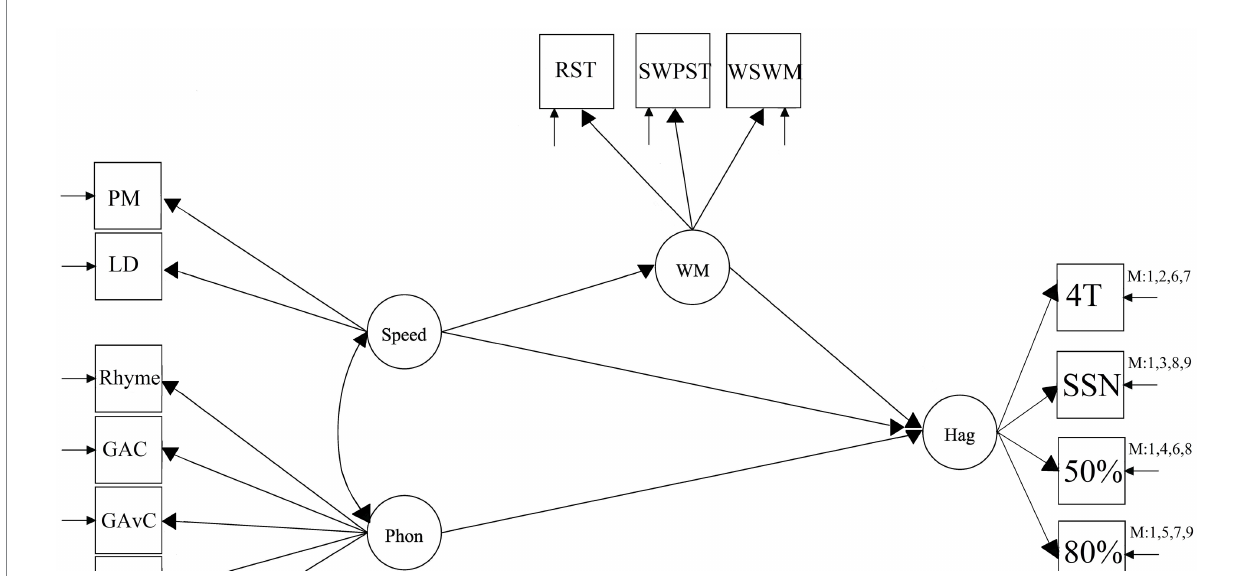
FIGURE 1 SEM mediation model where speed is mediated via WM and Speed and Phon (phonology) allowed to directly predict outcome-Hag (Hagerman). Phonology and speed are allowed to correlate. Speed is predicted by PM (Physical matching speed) and LD (Lexical Decision speed). Phonology is predicted by Rhyme and Gating conditions (G = Gating, AC = Audio Consonant, AvC = AudioVisual Consonant, AV = Audio Vocal, AvV = AudioVisual Vocal, i.e., a RAMBPHO composite). WM is predicted by RST (Reading Span Task), SWPST (Semantic Word Pair Span), and WSWM (Visuo-spatial WM test). Hag = Hagerman and is predicted by all the different conditions of the Hagerman test including 4T (Four Talker Babble), SSN (Speech Shaped Noise), 50/80% threshold. M: followed by numbers represents the different conditions included in the different models. The disconnected arrows indicate that the model accounts for